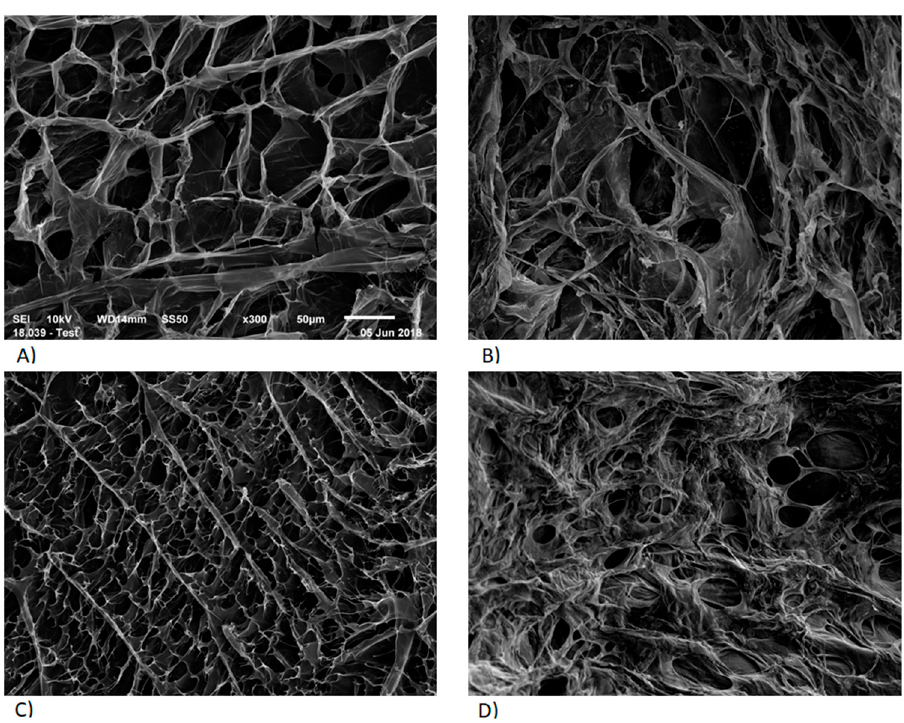
Figure 4. SEM micrographs of the internal structure of freeze-dried in situ gelling systems. Formulation A without PHE and TPC, before ( A ) and after addition of STF ( B ). Formulation C without PHE and TPC, before ( C ) and after addition of STF ( D ).